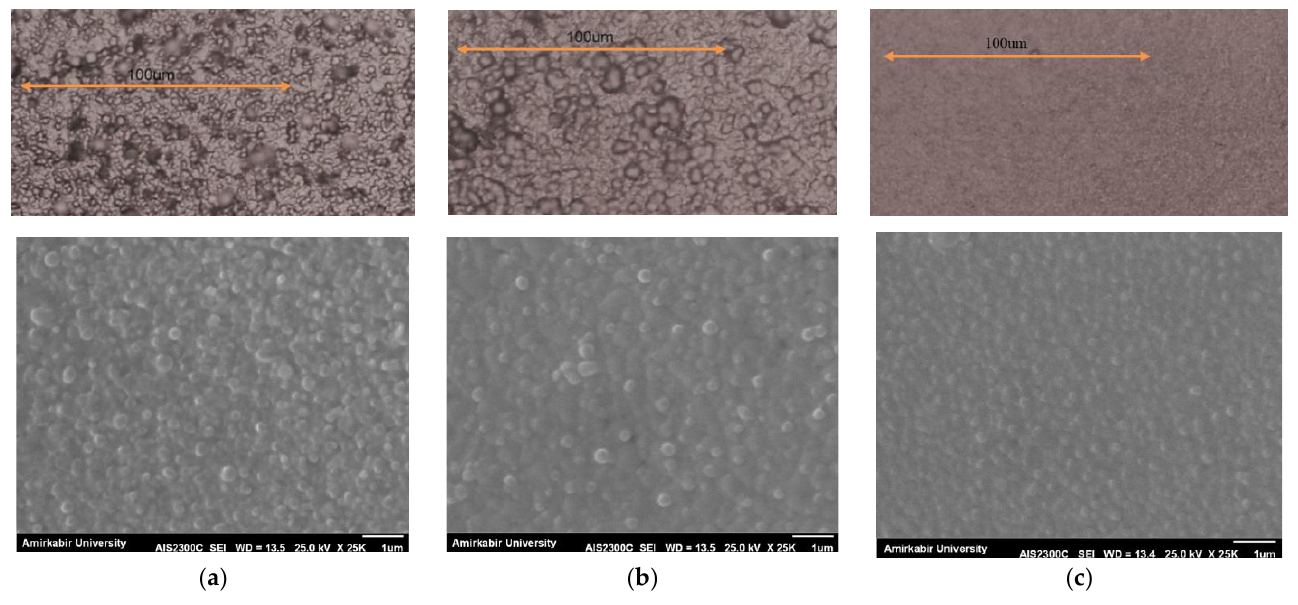
Figure 10. Optical microscope and SEM images of nickel deposited layer surface with a current density of 20 mA/cm 2 , stirring speed of 110 rpm, deposition duration of 30 min, and beam width of 50 μ m; ( a ) RTD 2, surface roughness (Ra) = 0.34 μ m; ( b ) RTD 3, surface roughness (Ra) = 0.19 μ m; ( c ) 50 µ m; ( a ) RTD 2, surface roughness (Ra) = 0.34 µ m; ( b ) RTD 3, surface roughness (Ra) = 0.19 µ m; RTD 4, surface roughness (Ra) = 0.08 μ m. ( c ) RTD 4, surface roughness (Ra) = 0.08 µ m.